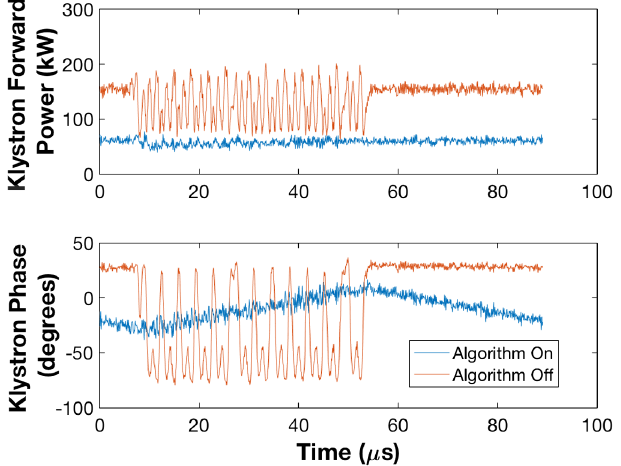
FIG. 13. Klystron forward power per turn. 1164 bunches, beam